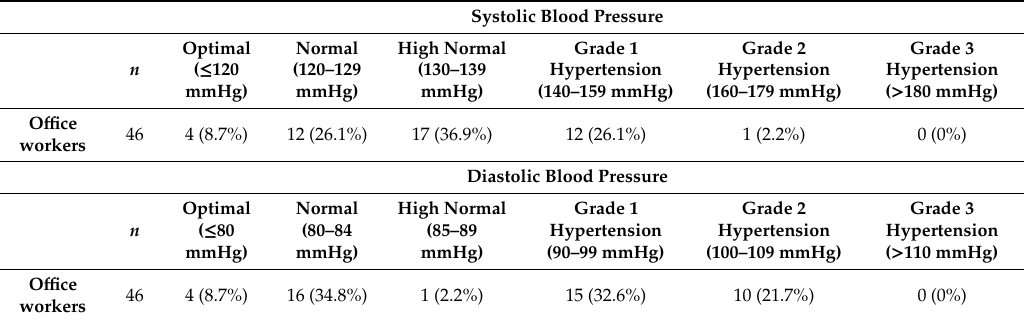
Table 2. Classification of systolic and diastolic blood pressure in degrees of severity